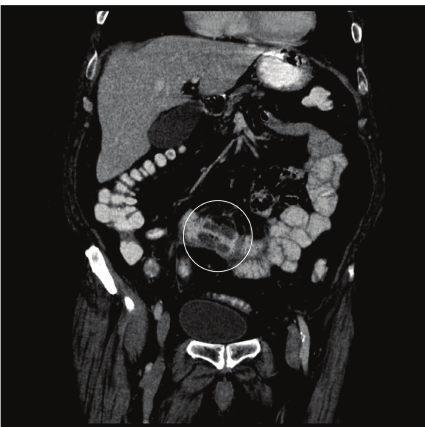
Figure 1: Apple core lesion in small bowel, see circle (computed tomography).